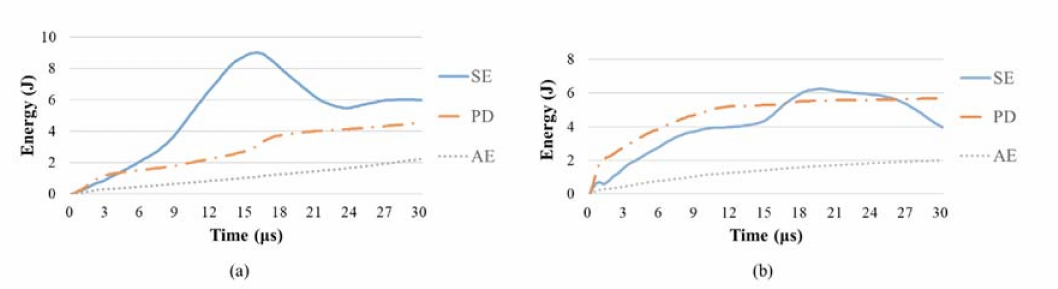
Figure 7. Time history of different forms of strain energy in ( a ) 5-AI and ( b ) 3-plain.